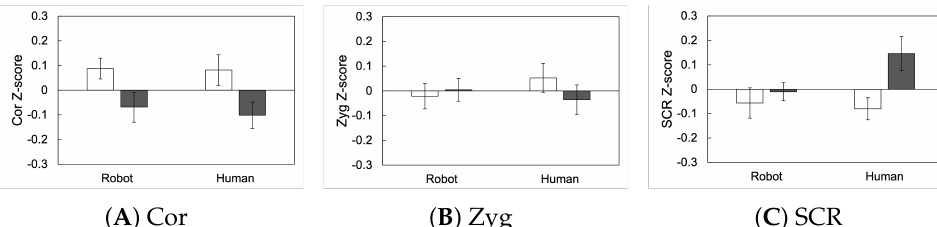
Figure 7. The mean with SE of the subjective evaluation. (***: p < 0.001, *: p < 0.05, n.s.: p > 0.10).